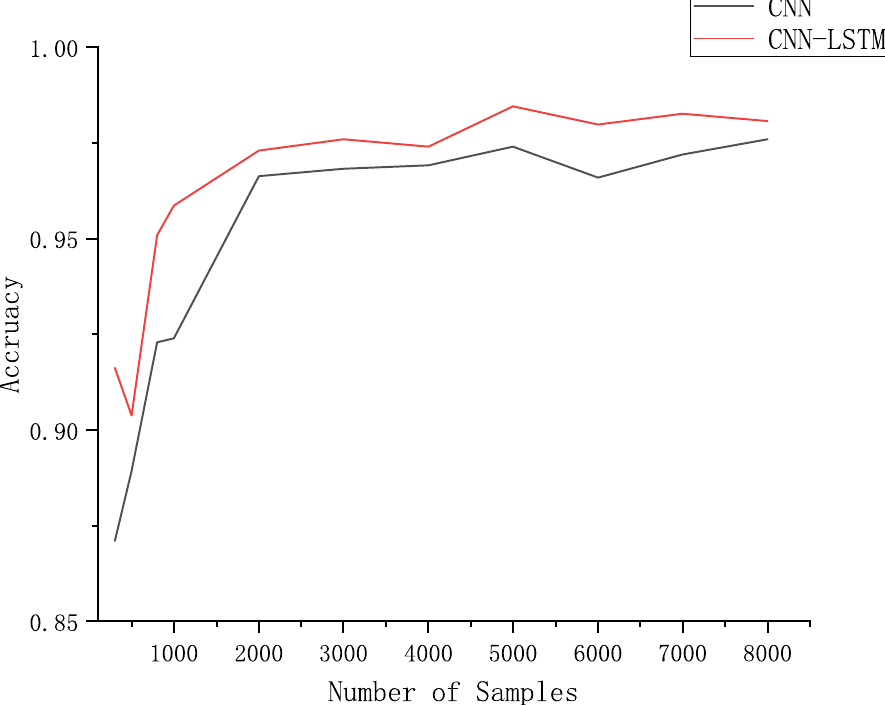
Figure 18. Accuracy of CNN models and CNN-LSTM models on datasets with different amounts of